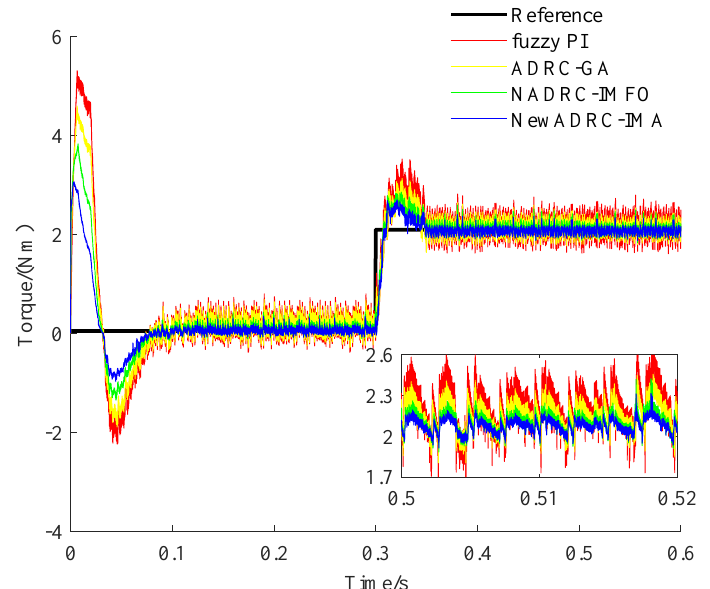
Figure 9. The torque curves under the first PMSM velocity control practical